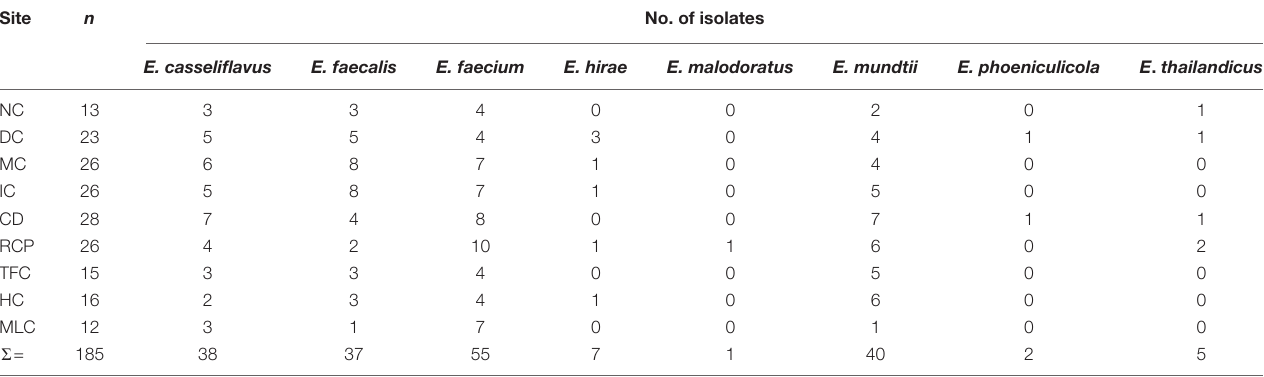
TABLE 3 | The number of Enterococcus spp. isolated from the irrigation return flows and background canal site (MLC) that v/ere characterized for antibiotic resistance in the present study. Site n